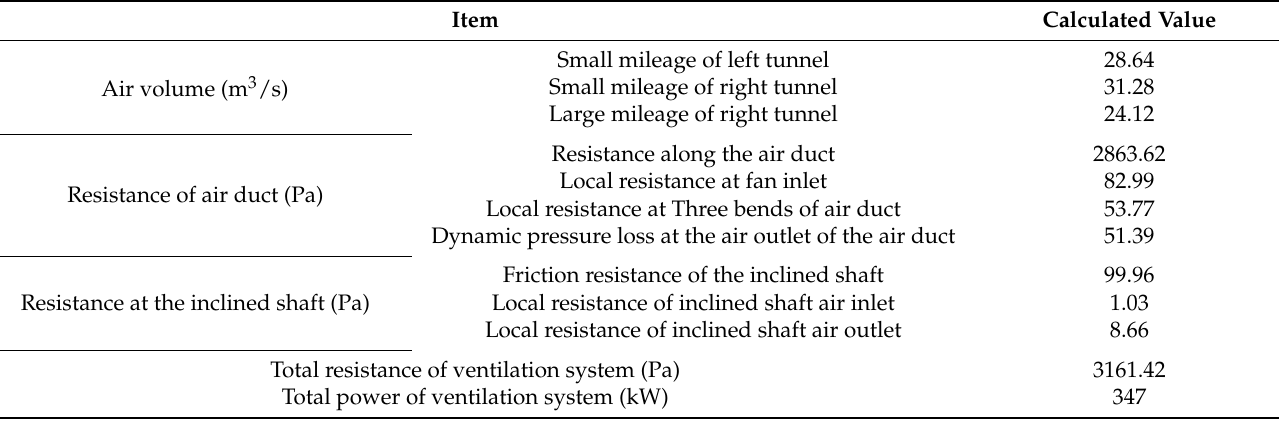
Table 3. Energy consumption of a blowing ventilation system.